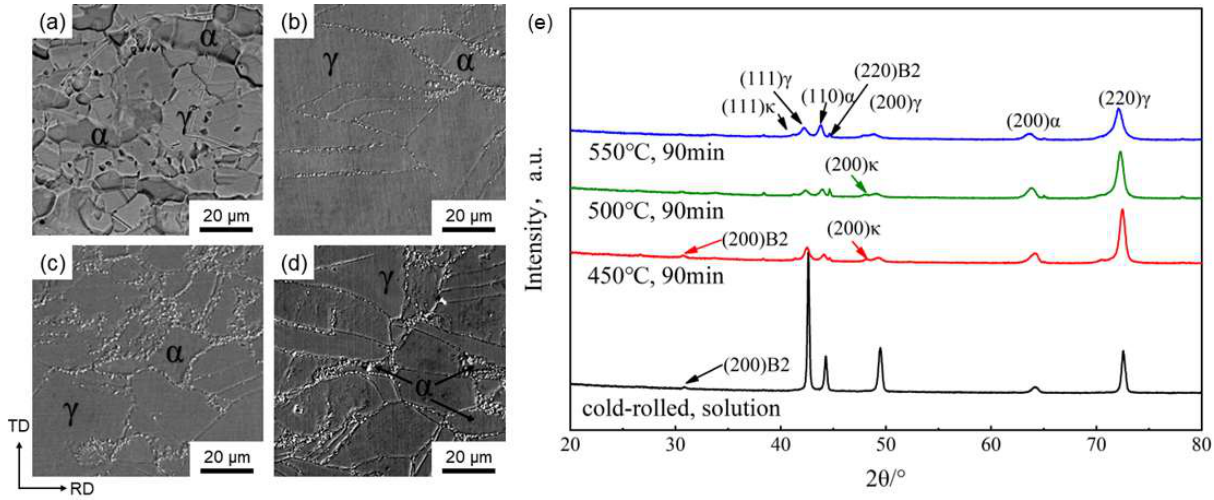
Figure 3. Microstructure images of ( a ) S1000, ( b ) A450, ( c ) A500, ( d ) A550 after heat treatment and ( e ) XRD patterns.